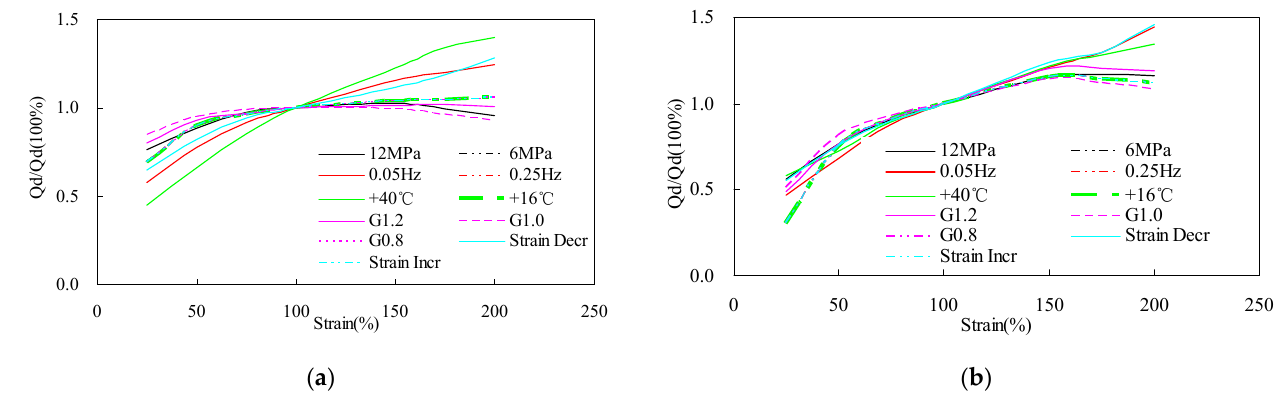
Figure 5. The mechanic properties d of the bearings under different conditions: ( a ) LRB; ( b ) SHDR. For SHDR, Figure 5b shows the influence of the different factors on the shear strain Q . In comparison to LRB, the difference of the factors’ effect on SHDR dependency of d becomes less. Excluding the 200% strain, the temperature and loading sequence may be the largest impact factors. The influence of the loading frequency is small at the small shear strain stages and is large at the large shear strain stages. There is a similar small effect for the G value and pressure. Figure 6a shows how the different factors affect the shear strain dependency of the area of a single cycle of LRB’s hysteretic loop. It can be observed that for all of the factors, there is little effect at the small shear strain stages, while some influence can be found at the large shear strain stages, i.e., 150%, 175%, 200%. For all of the factors, the temperature may still be the biggest one of impact, such as at the 200% strain where there is about a 25% increment from 16 to 40 °C. The loading sequence and loading frequency may be the second ones of impact. In these two factors, there is little difference, as the maximum in- crement is about 20% at 200%. The third ones of impact may be the pressure and G value; there are few changes from 6 to 12 Mpa or from the G value of 0.8 to 1.0 MPa and 1.2 MPa.